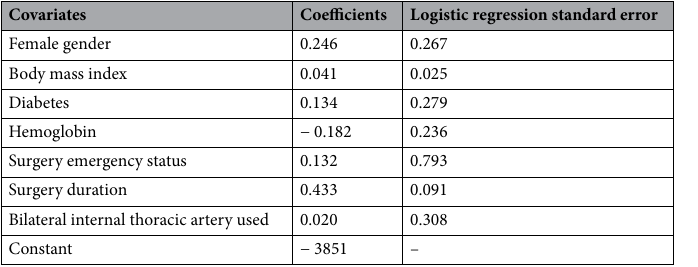
Table 2. LASSO logistic regression tenfold cross-validation coefficients. REPINF, REPLICCAR II, São Paulo, Brazil, 2017–2019.